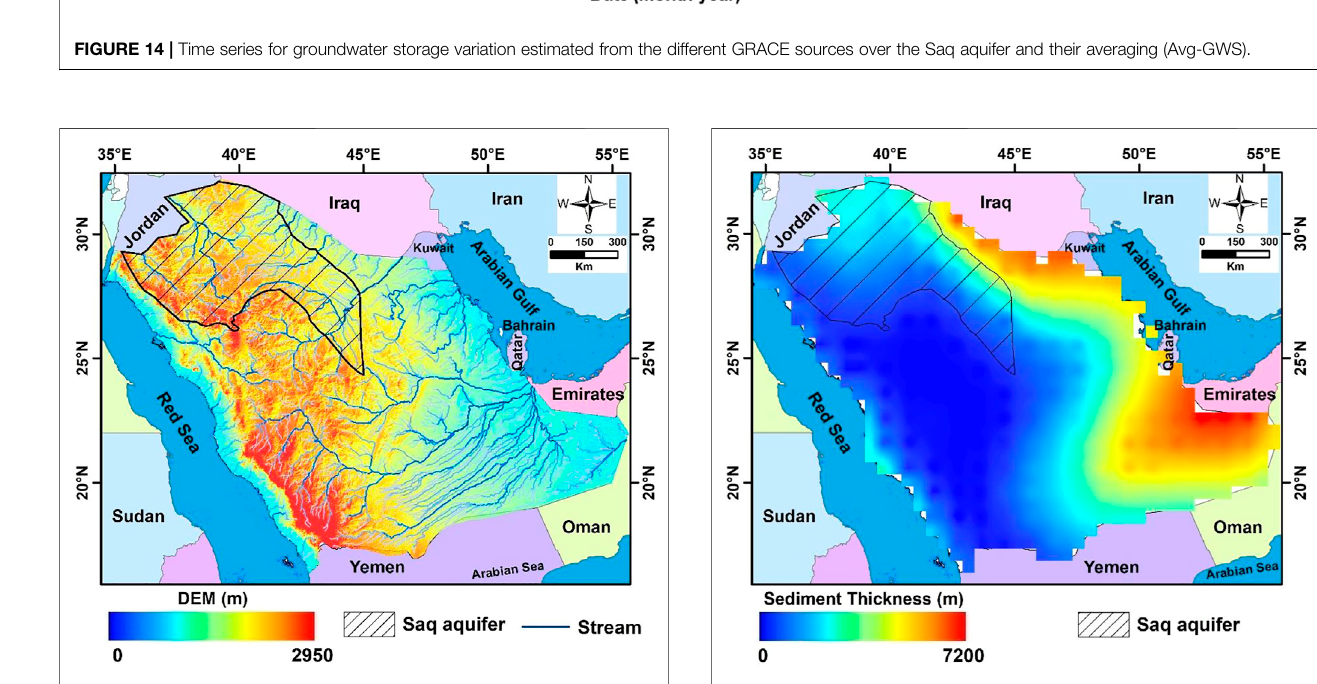
FIGURE 15 | A map of the ground surface elevation based on a Digital Elevation Model (DEM) of the entire study area. The Saq aquifer ’ s distribution and the area ’ s stream networks are also shown.